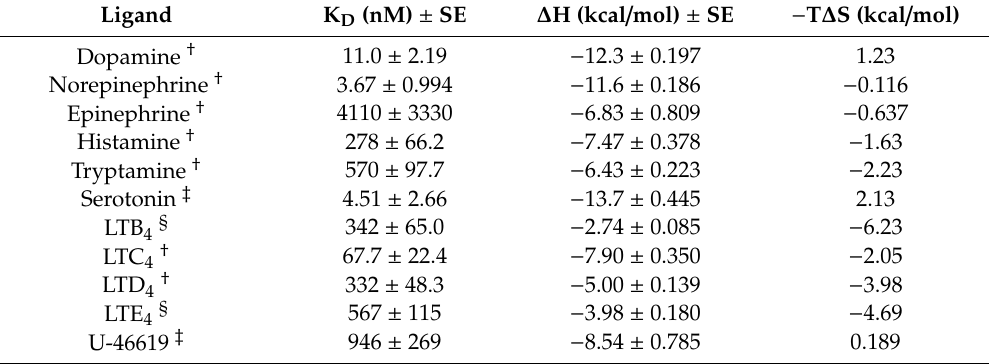
Table 1. Binding a ffi nities of AlboD7L1 with biogenic amine and eicosanoid ligands measured by isothermal titration calorimetry (ITC).